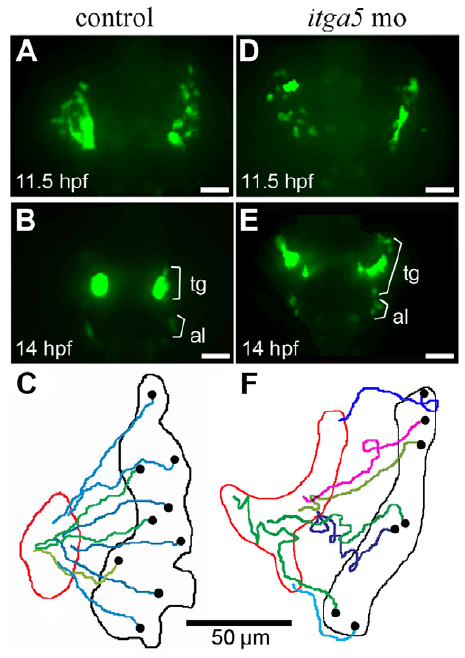
Figure 5. Convergence of trigeminal precursors is impaired in itga5 morphants. ( A, B, D, E ) Images of time-lapse movies showing transgenic neuroD:EGFP expression in the first (11.5 hpf) and final (14 hpf) frames of a control movie (A, B) and itga5 morphant movie (D, E). Positions of precursors of the trigeminal ganglion (tg) and anterior lateral line (al) are indicated. ( C, F ) Maps showing the trajectories of individual trigeminal precursors in the control embryo (C) and itga5 morphant (F). Black and red boundaries mark the initial and final distribution, respectively, of neuroD:EGFP -positive trigeminal precursors. Black dots represent the initial and final positions, respectively, of individual cells. Images show dorsal views with anterior to the top, and summary figures show the right trigeminal field of each embryo, with lateral to the right. Scale bar, 50 m m.